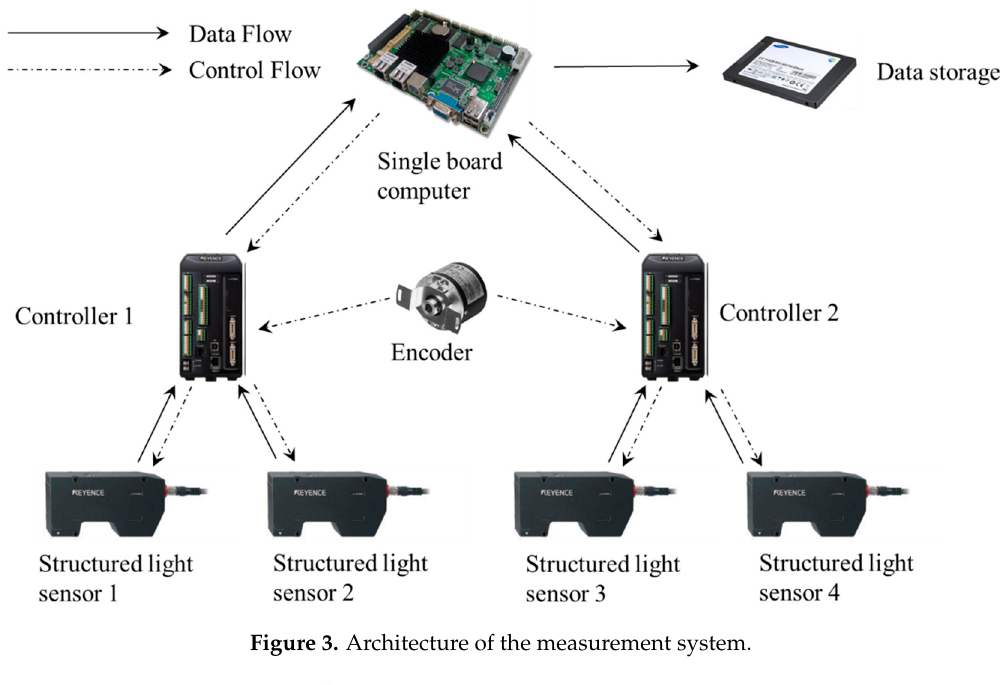
Figure 3. Architecture of the measurement system.